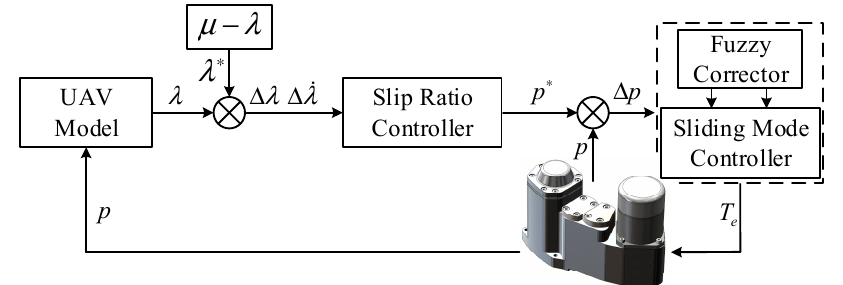
Figure 6. Structure of the UAV antiskid braking system.